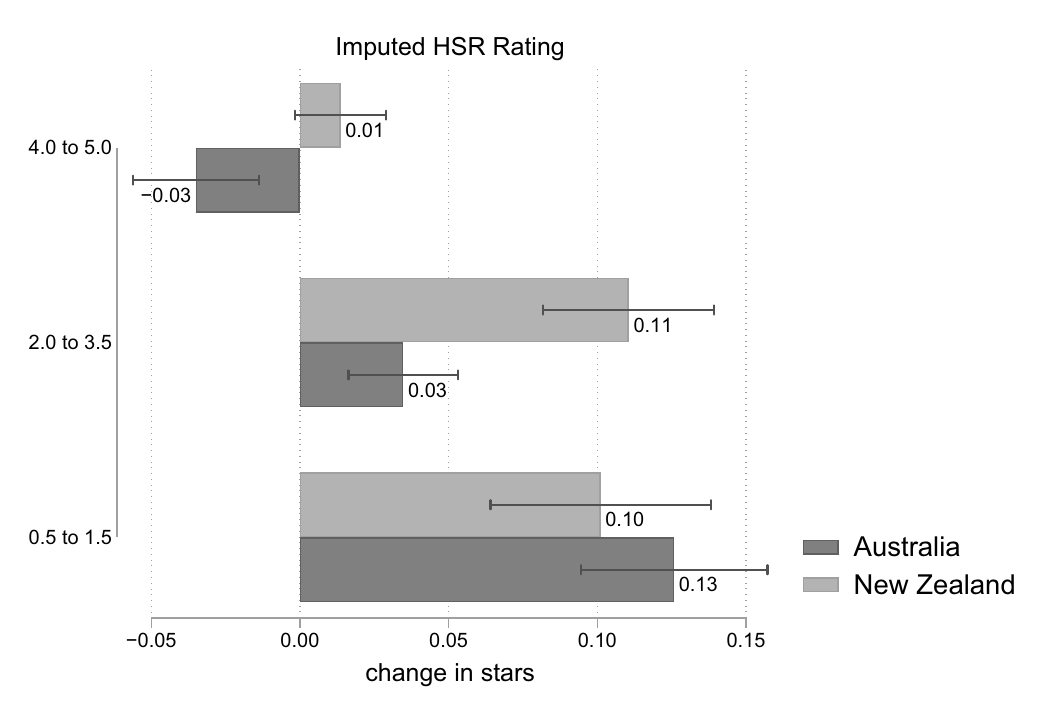
Fig 3. Stratified analyses on the change in imputed HSR rating by pretreatment HSR—4.0 to 5.0 (most nutritious), 2.0 to 3.5, and 0.5 to 1.5 (least nutritious). Regression estimates and 95% CIs displayed. Data used to construct this figure are in S3 Text. CI, confidence interval; HSR, Health Star